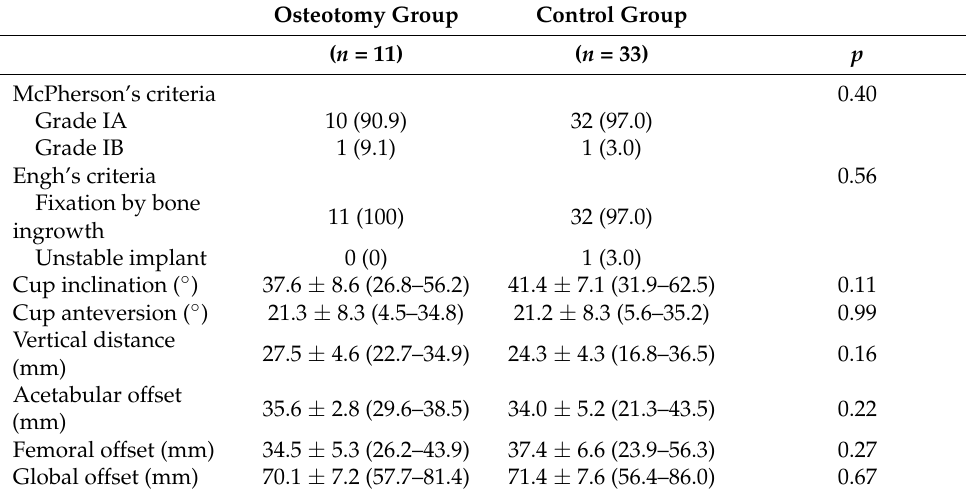
Table 4. Radiographic